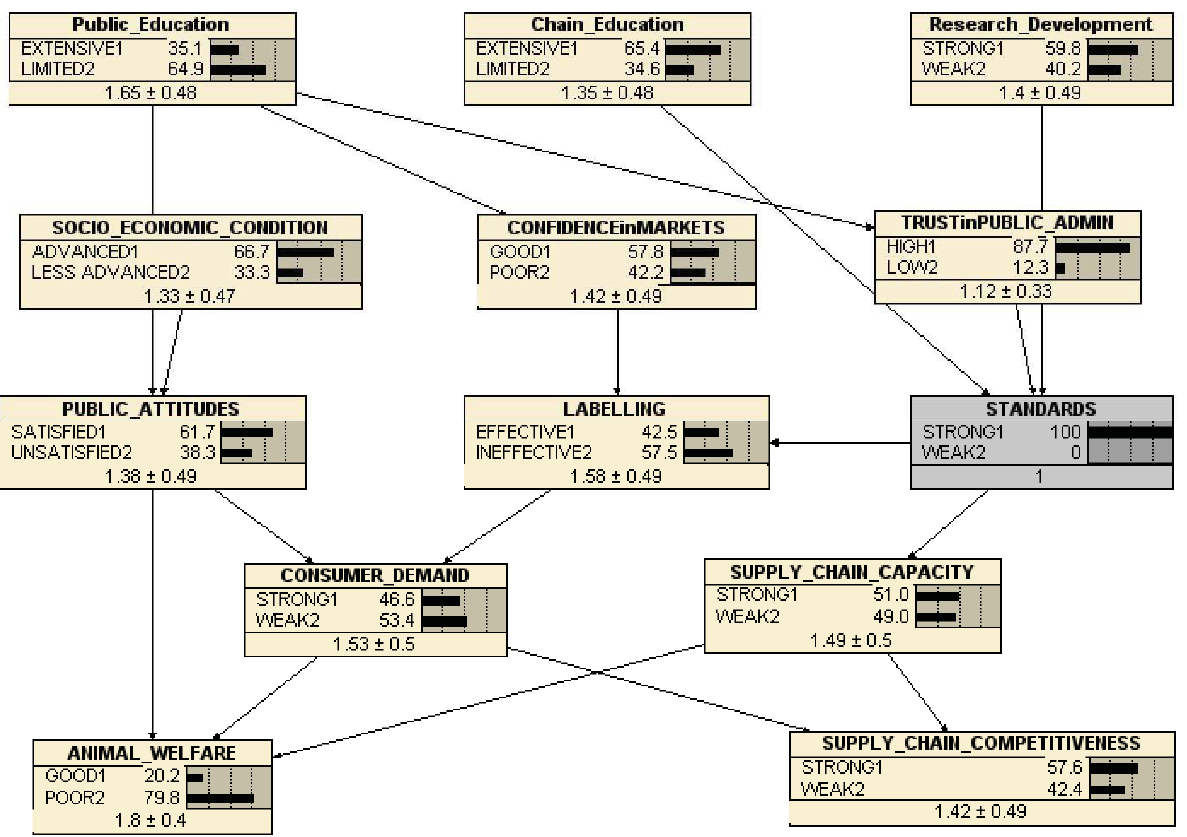
Figure 5. Network consequences of Improved